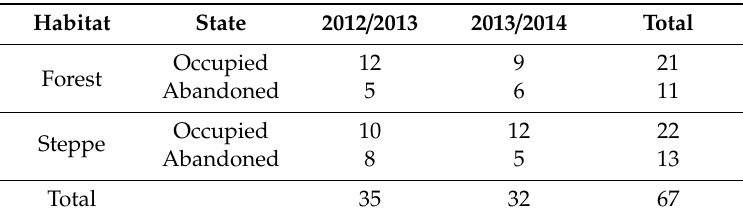
Table 2. Summary of the number of beaver lodges occupied and abandoned in both periods. Note that from the 32 lodges sampled in 2013 / 2014, N = 20 were already sampled in 2012 / 2013 resulting in 47 di ff erent lodges in the total.